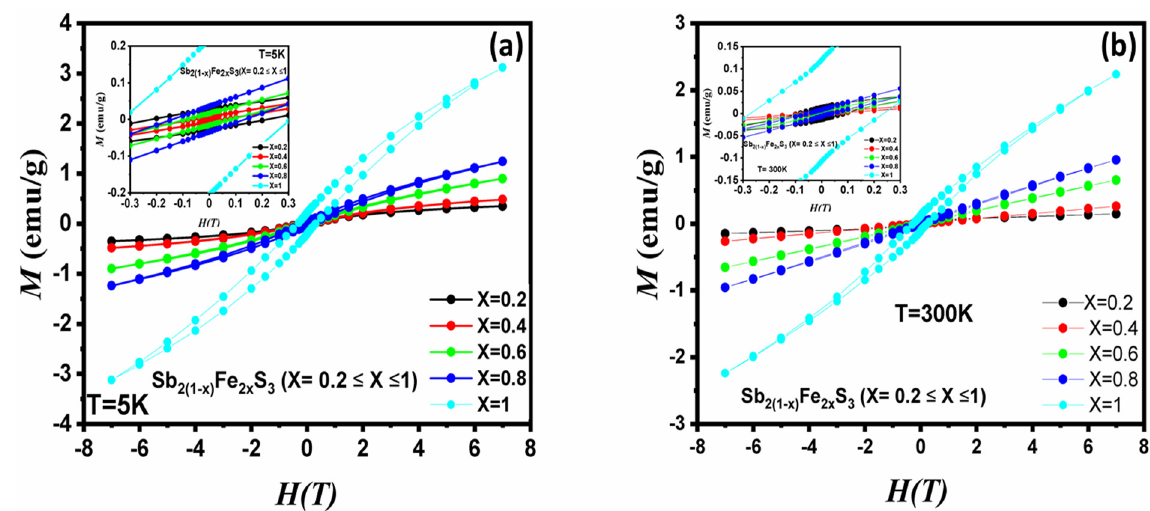
Figure 9. Hysteresis loops at ( a ) 5 K and ( b ) 300 K for Sb 2(1 − x ) Fe 2 x S 3 (0.2 ≤ x ≤ 1). The inset is a zoom of the region around the zero field. Table 1. Coercive field, maximum magnetization at 7 T, and remnant magnetization values at 300 and 5 K, based on Figure